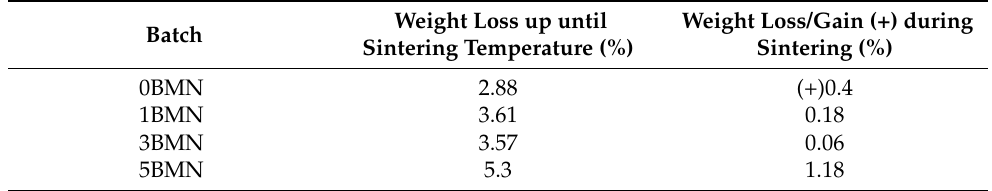
Figure 3. TGA curves for 0BMN, 1BMN, 3BMN, and 5BMN during sintering at 1100 ◦ C for 3 h in the air. Table 2. Weight loss/gain (+) during sintering.